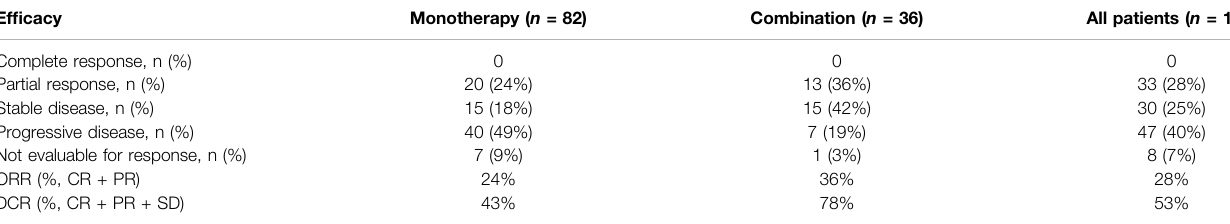
TABLE 4 | Disease response in PD-1 inhibitor and